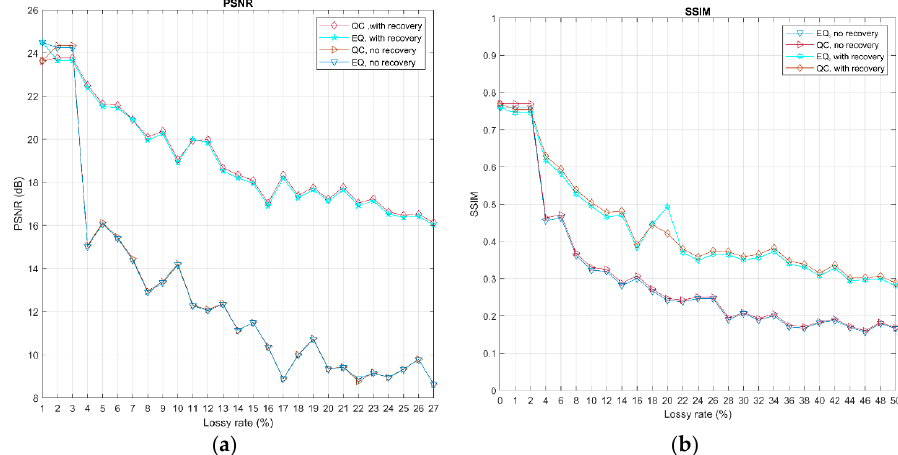
Figure 6. Reconstructions for EQ and QC constraints for cameraman with different lossy probabilities: ( a ) Peak Signal-to-Noise (PSNR) curves and ( b ) Structural Similarity (SSIM) curves.